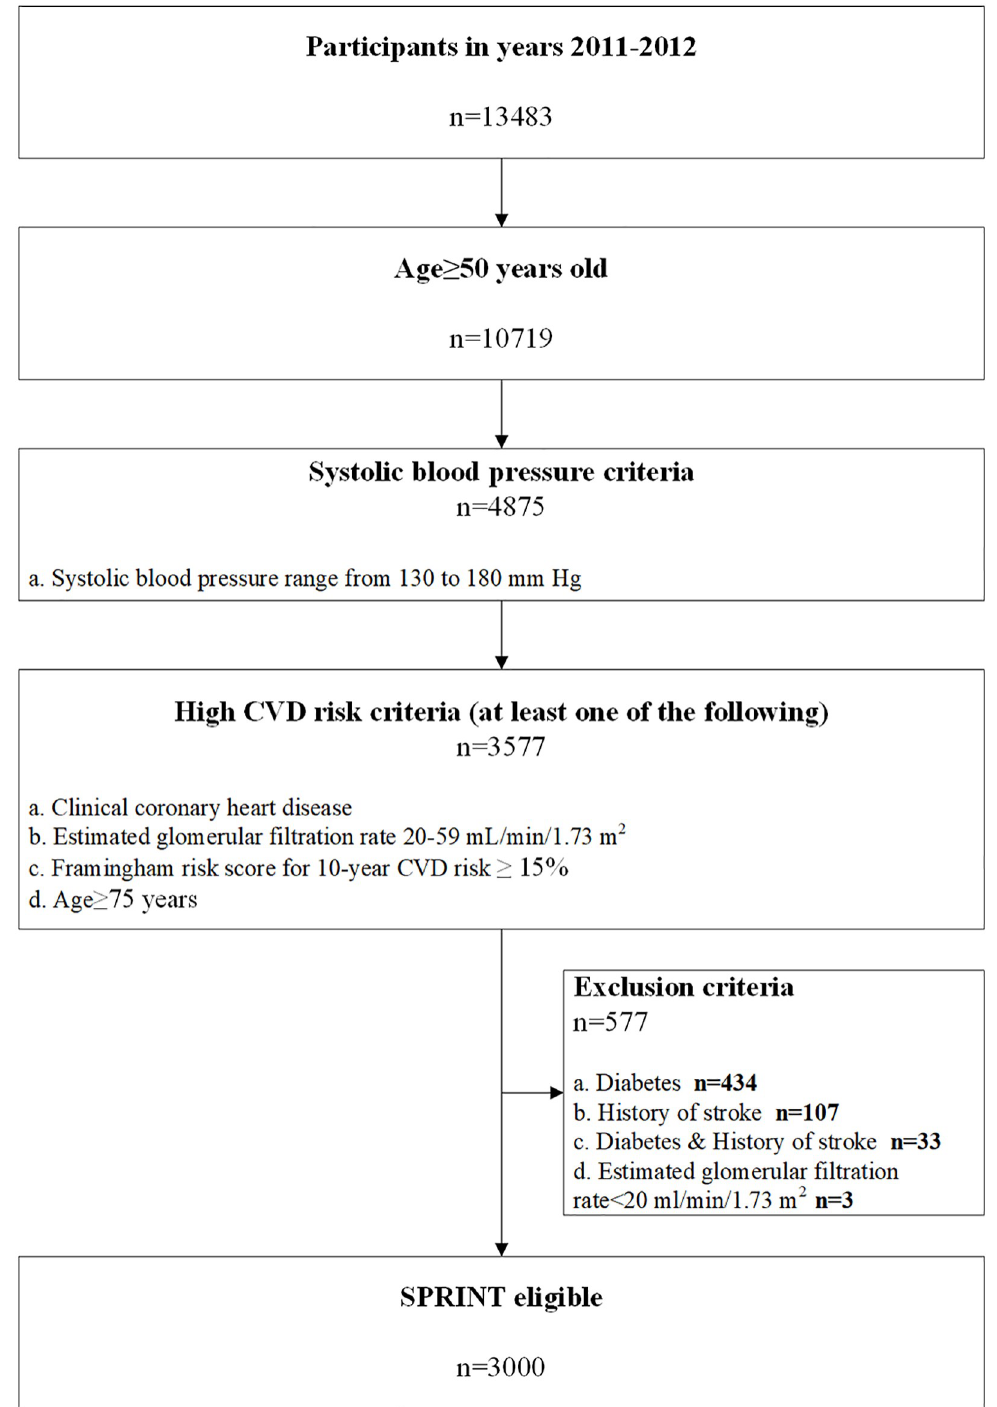
Fig 1. Flow chart showing the eligibility criteria for SPRINT applied to the present study. Total number of baseline participants of the China Health and Retirement Longitudinal Study was 17,708. After excluding missing blood pressure values, there were 13,483 eligible participants included in the present analysis. CVD, cardiovascular disease; SPRINT, Systolic Blood Pressure Intervention Trial.